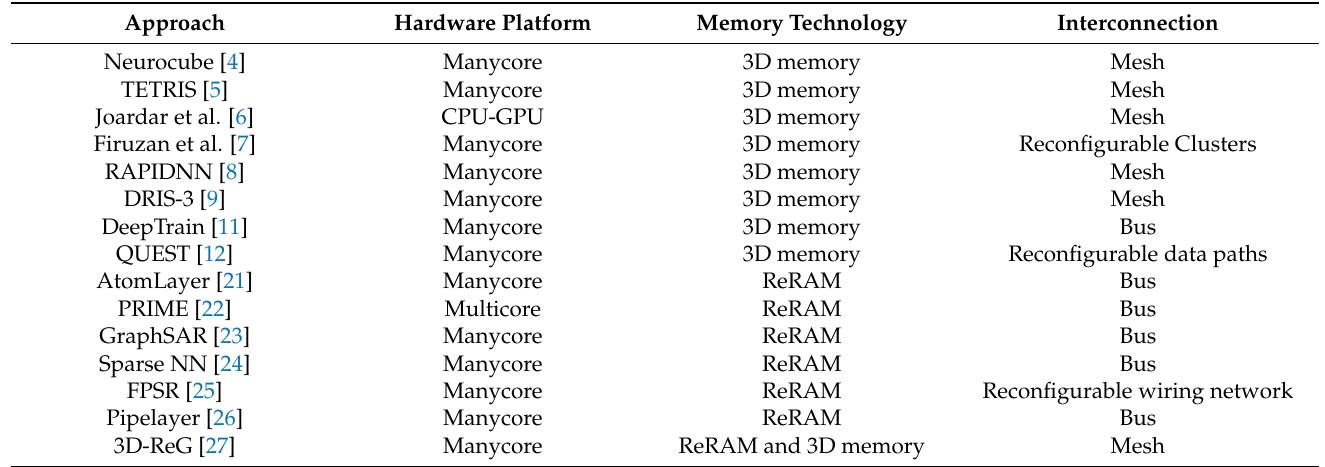
Table 1. Summary of memory architectures in DNN accelerators.